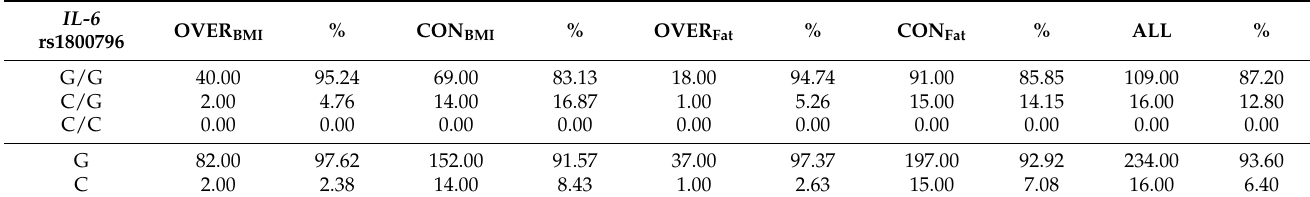
Table 5. Division of genotypes and alleles in the IL-6 gene (rs1800796).